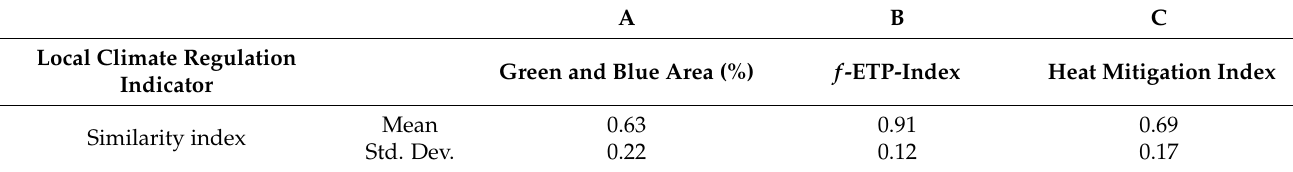
Table 4. Similarity values of the map comparison between the maps from expert estimates (expert- based ES matrix approach) and the indicators (A) green and blue area (%) (LULC data); (B) f -ETP- Index (literature data); (C) heat mitigation index (InVEST model Urban Cooling) in the urban region of Munich. Values: 0 indicates no similarity, and 1 very high similarity between the compared maps. A B C Local Climate Regulation Green and Blue Area (%) f -ETP-Index Heat Mitigation Index Indicator Mean 0.63 0.91 Similarity index Std. Dev. 0.22 0.12